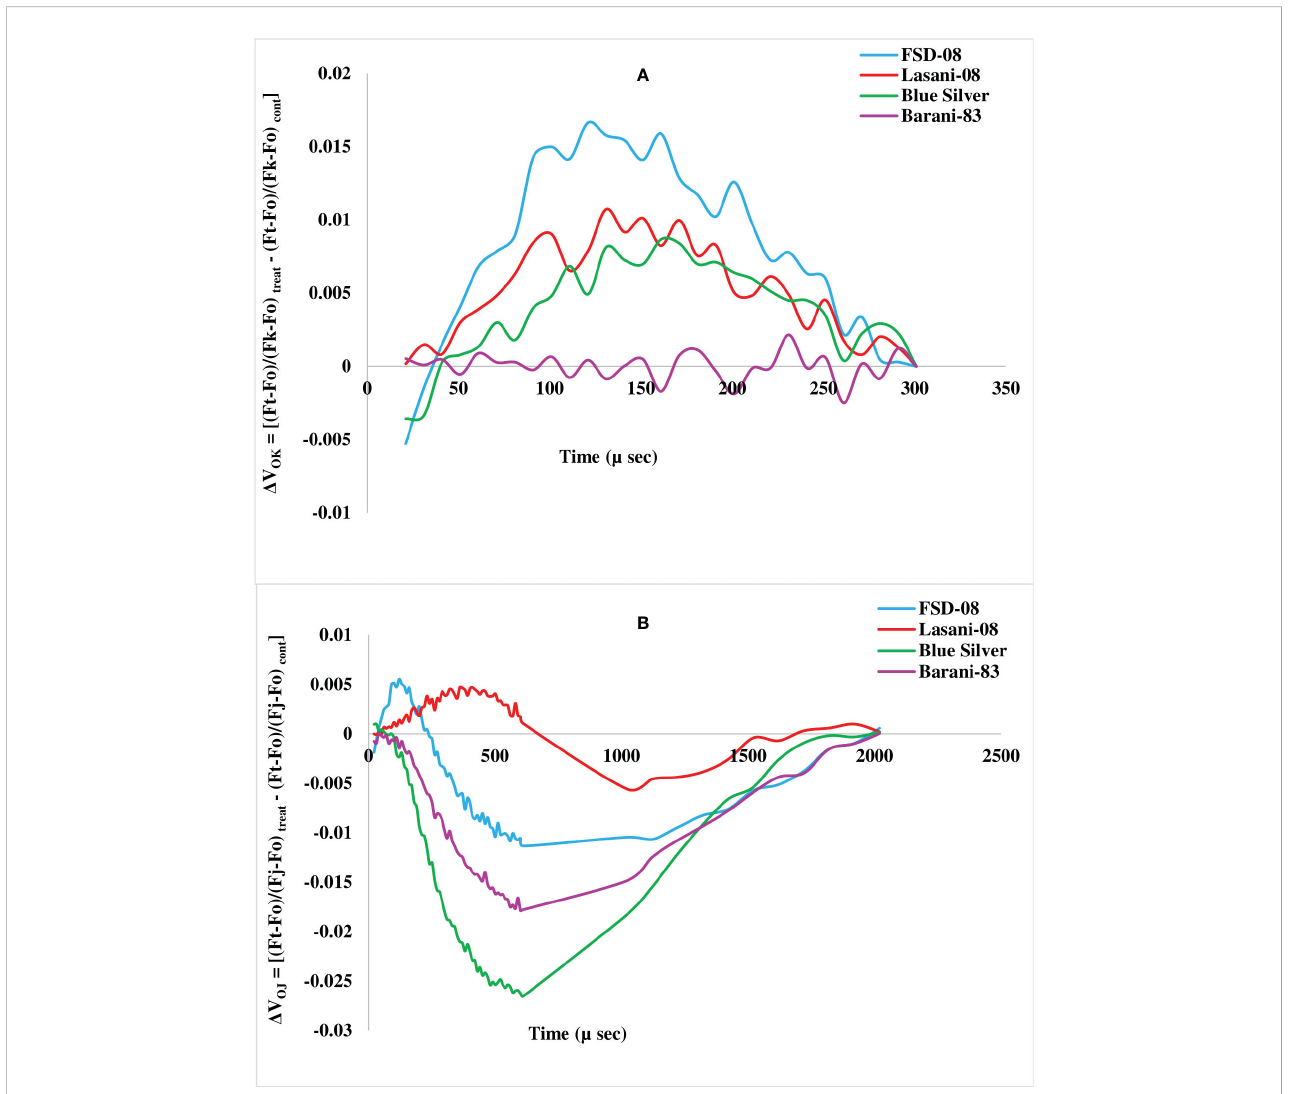
FIGURE 9 Kinetic differences of four selected wheat cultivars subjected to control or drought stress at adult stage. (A) Double normalized between Fo and Fk (L- band). (B) Double normalized between Fo and Fj (K